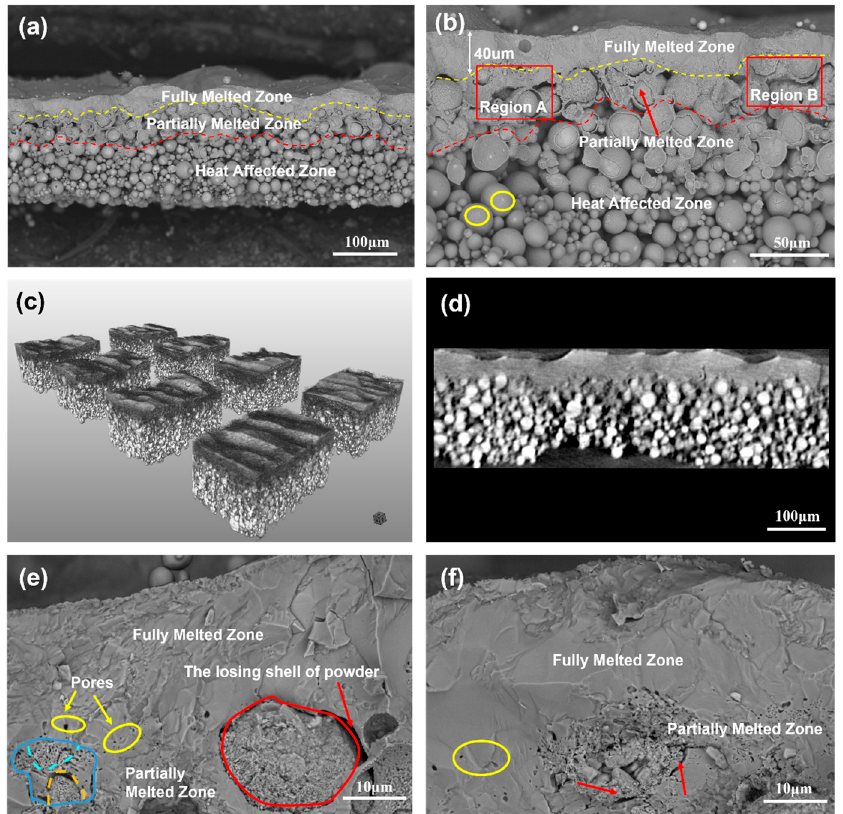
Figure 8. Characteristics of cross-sectional morphology: ( a ) SEM image of the overall cross-sectional morphology of the sample, ( b ) SEM image of local magnification of cross section, ( c ) A 3D XCT reconstruction of the single-layer sample within an observation volume of 740 μ m × 740 μ m × 180 μ m after being divided into eight pieces, ( d ) A single XCT slice of the cross section in ( c ) Within an observation size of 740 μ m × 180 μ m, ( e , f ) Morphology of transition area of fully melted zone and partially melted zone.